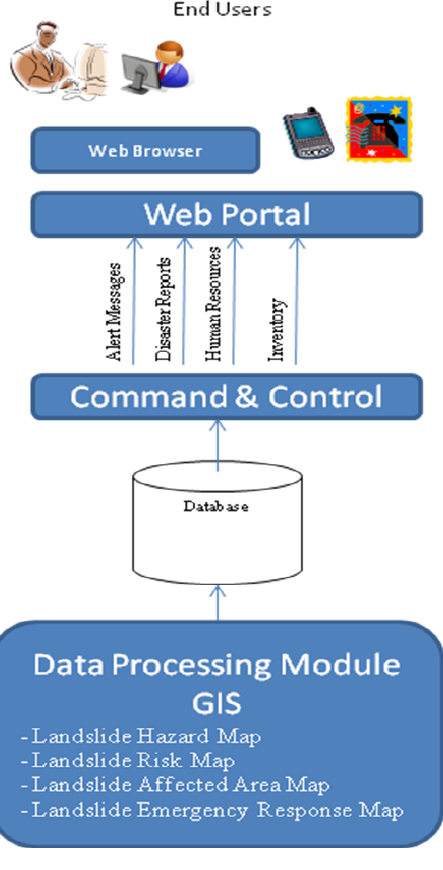
Figure 6. Configuration of the CCS and the communication disaster